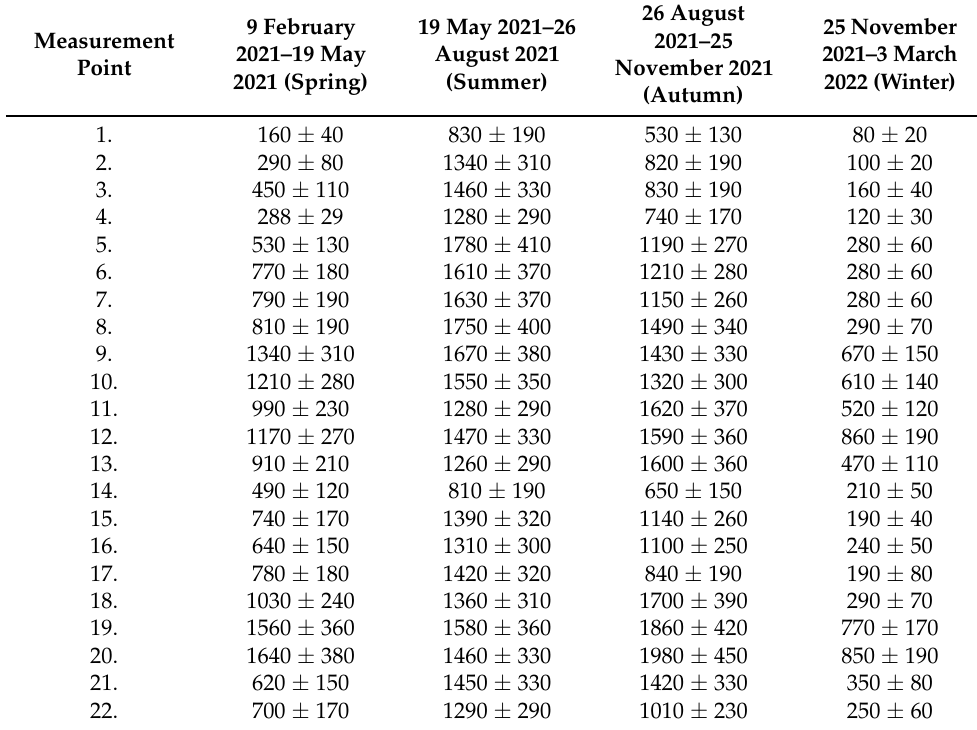
Table 1. Results of radon activity concentrations ± uncertainty at a 95% confidence level [Bq m − 3 ].